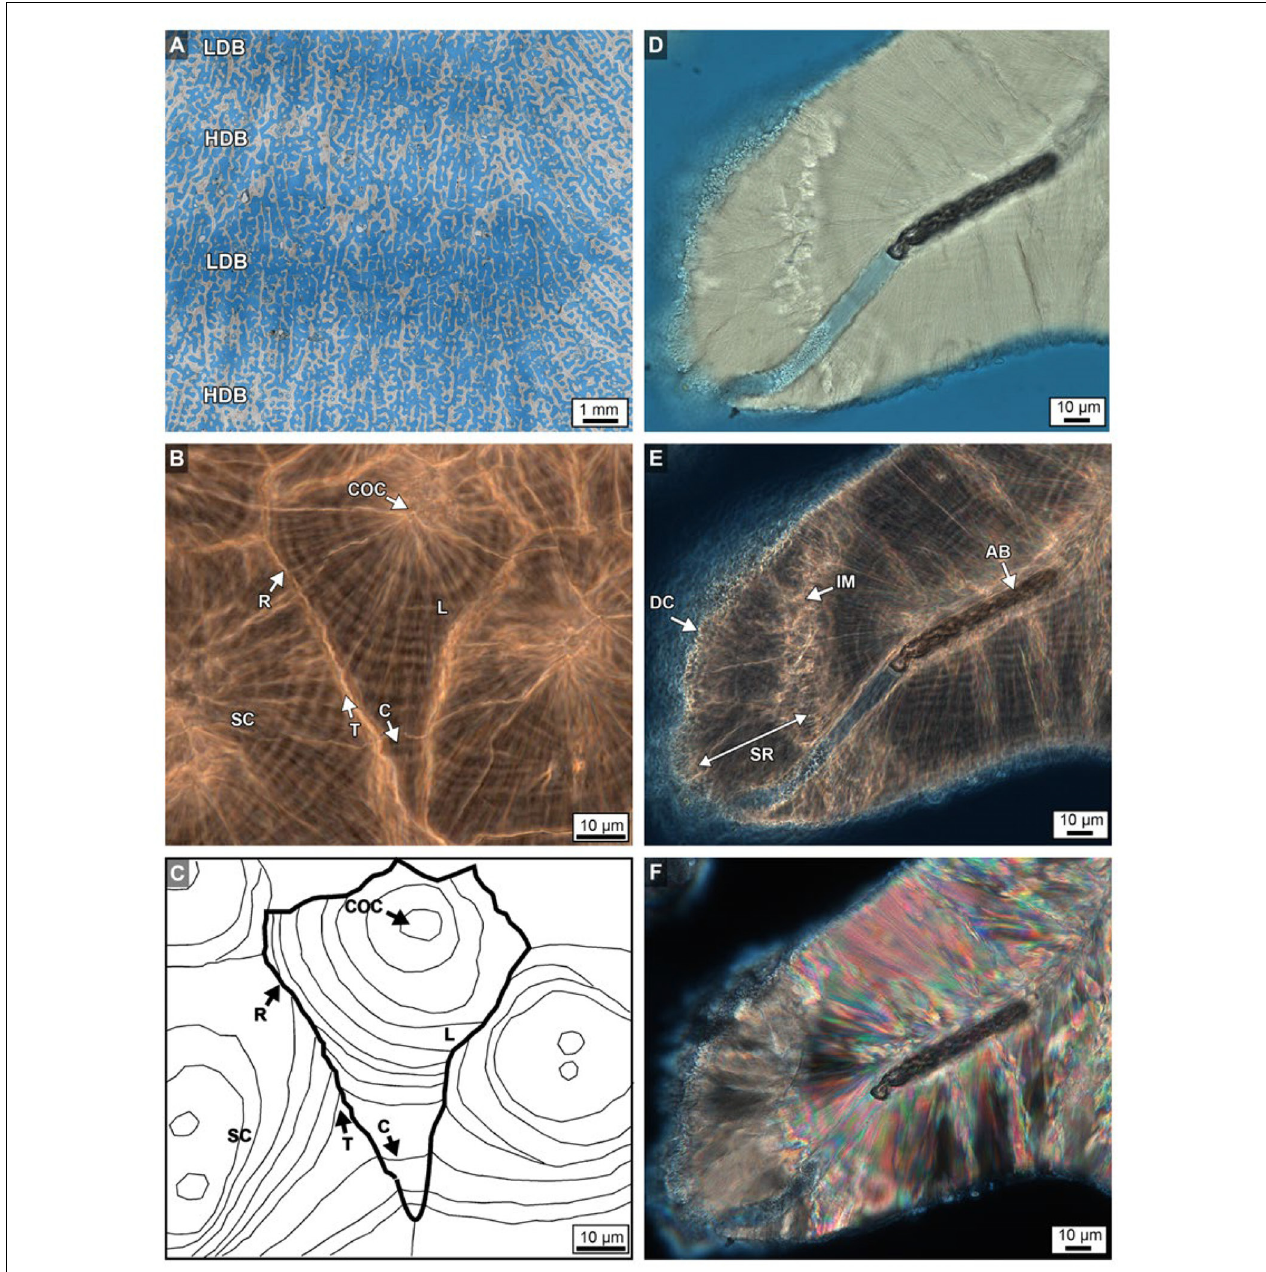
FIGURE 9 | (A) Brightfield (BF) image from near the top of Core 2 overlaid with a transparent XRD image that shows the precise location of high- and low-density bands (HDBs and LDBs). This illustrates the lateral thickening of original skeletal walls within HDBs with respect to LDBs (see also Figure 4 ). (B,C) Paired phase contrast (PC) image and its line tracing show the crystalline growth history of multiple sclerodermites (SC) that comprise skeletal walls within the bottom 3 cm of Core 3. Fine concentric layering (L) surrounding individual centers of calcification (COCs) within sclerodermites such as these occur throughout all four Porites cores. Layers are truncated (T) at their margins during early growth phases, yet become continuous (C) between sclerodermites during later growth phases. Sclerodermite margins are capped with a fine layer of replacement aragonite (R). BF (D) , phase contrast (PC; E and Supplementary Data Movie S2 ) and polarization (POL; F ) images of algal boring (AB), diagenetic cement (DC) and skeletal replacement (SR). The leading edge of the diagenetic replacement front forms an irregular margin